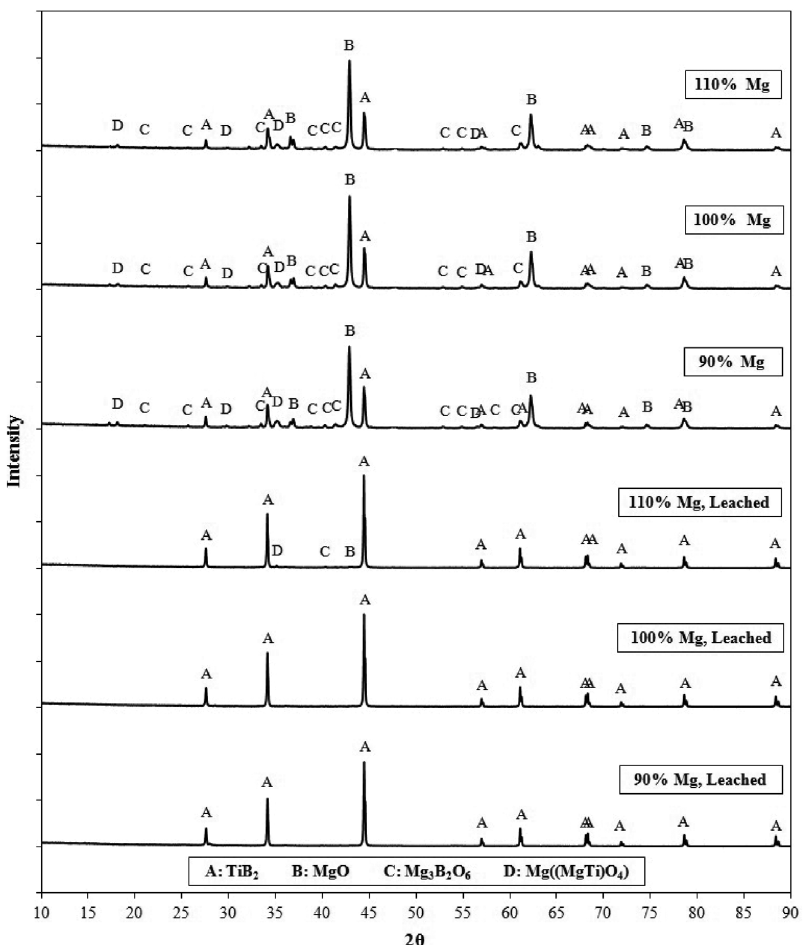
Fig. 3: XRD patterns of unleached and leached SHS products synthesized under argon